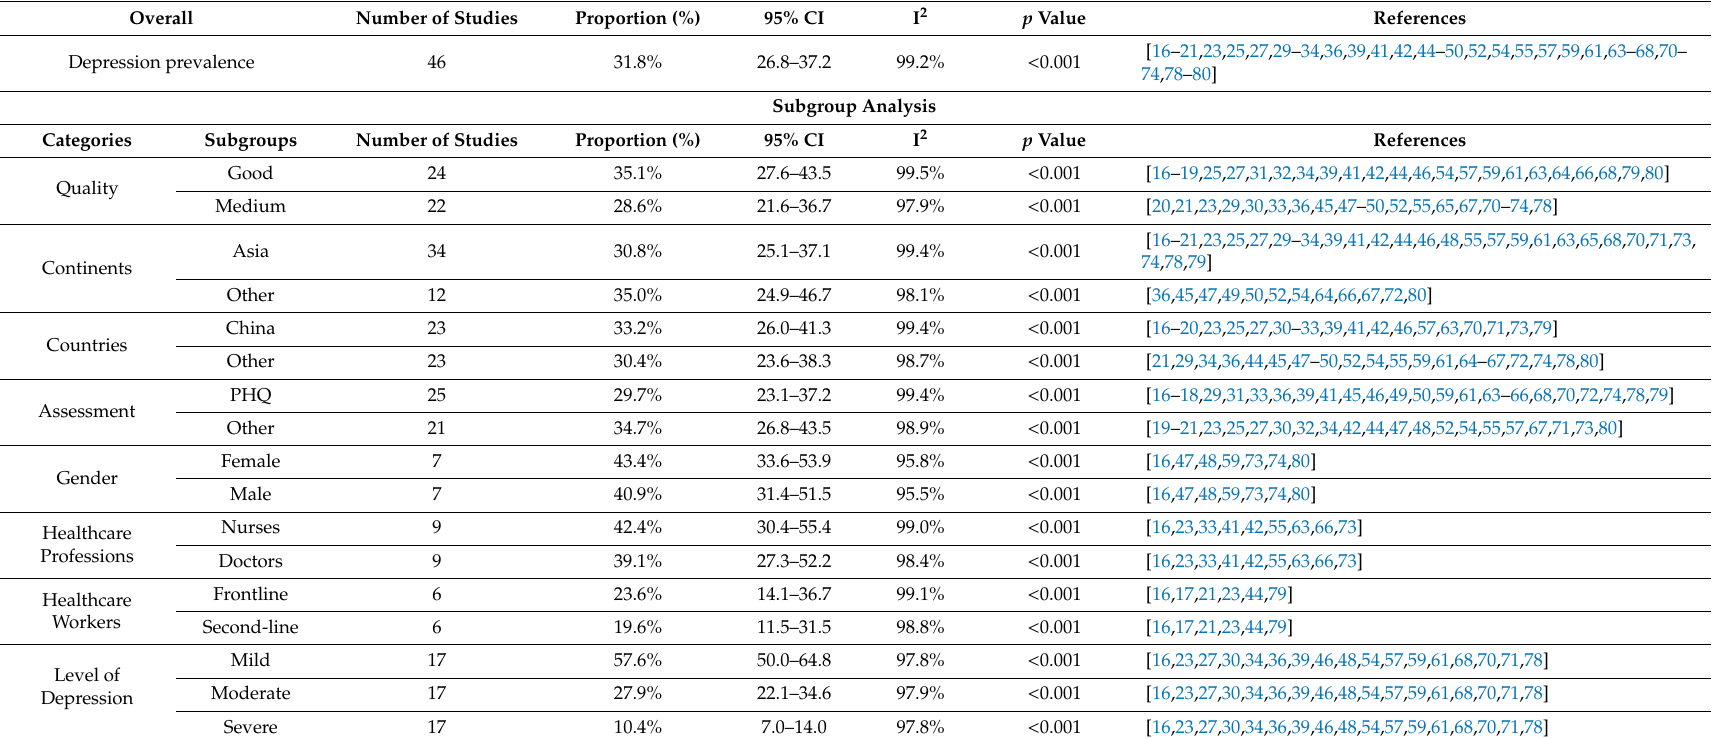
Table 2. Subgroup analyses of depression across di ff erent